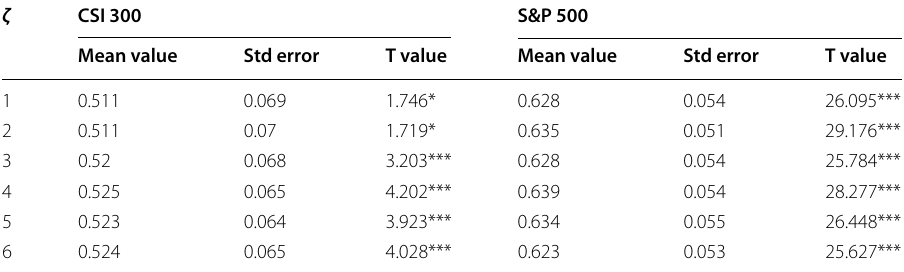
Table 7 Results of one-sample T tests by comparing the mean value to 0.50 in two stock